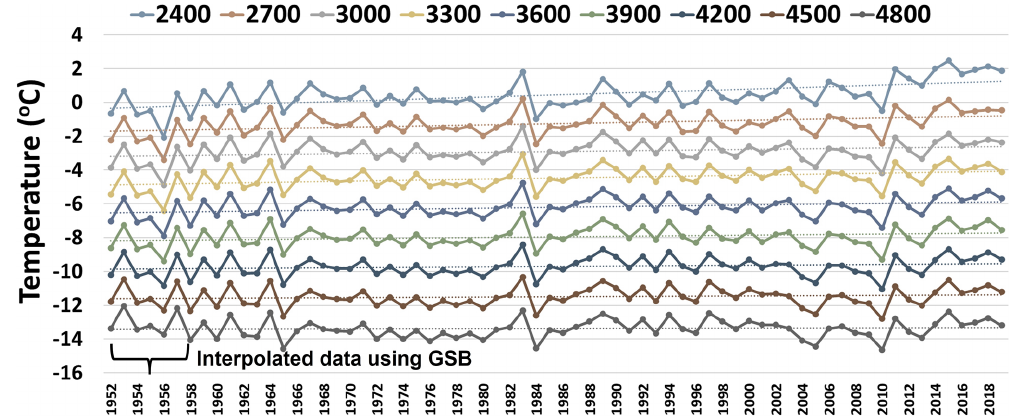
Figure 4. SAFRAN reanalysis product temperature time series from 1952–2019 for different elevations in the MBM. The figure shows the variation of the mean annual temperatures for the entire study period.